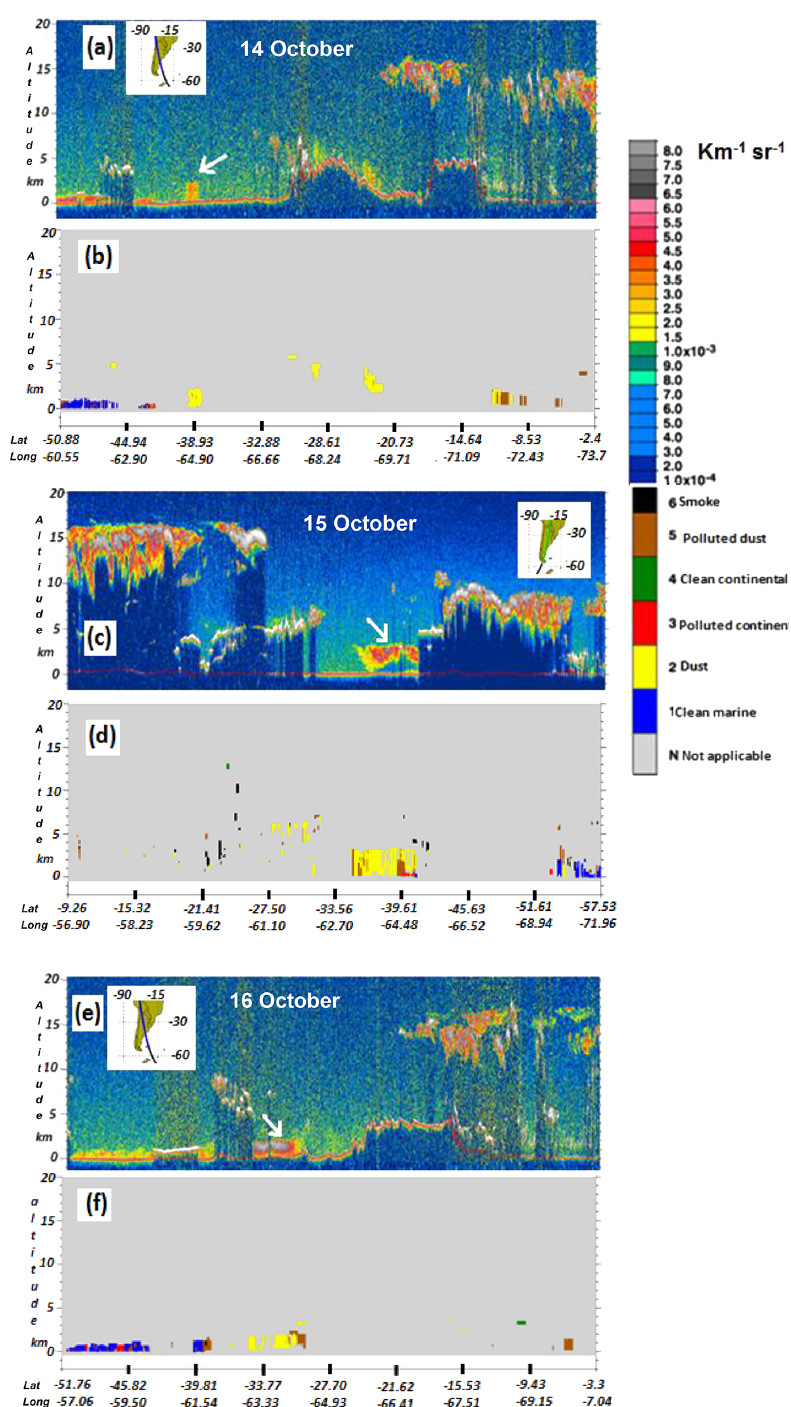
Figure 6. CALIPSO observations from 14 to 16 October 2011: (a, c, e) total attenuated backscatter at 532nm (km − 1 sr − 1 ); (b, d, f) aerosol subtype. The ground track is included in the insert.